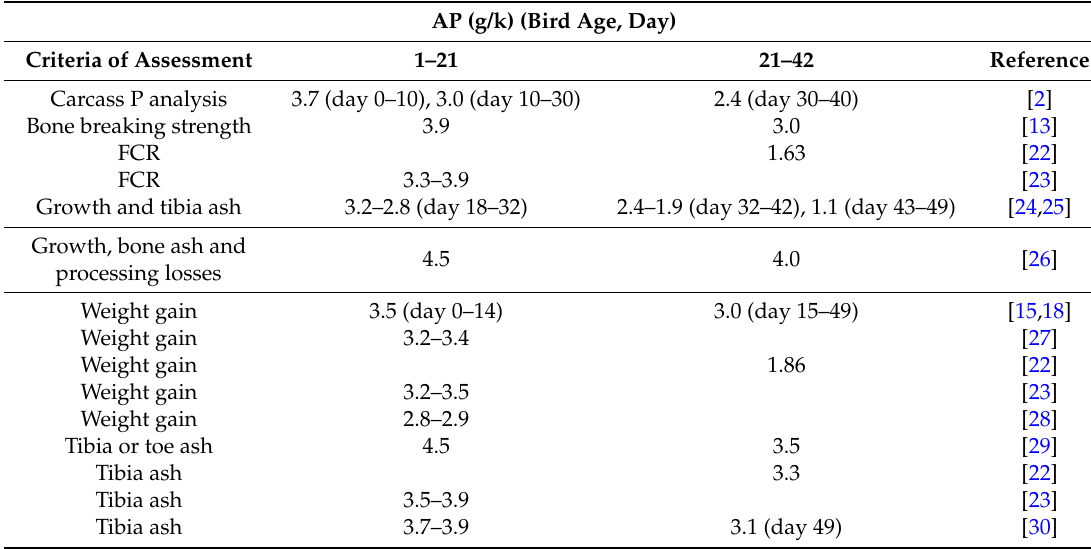
Table 1. Summary of available P requirements (g/kg diet) of